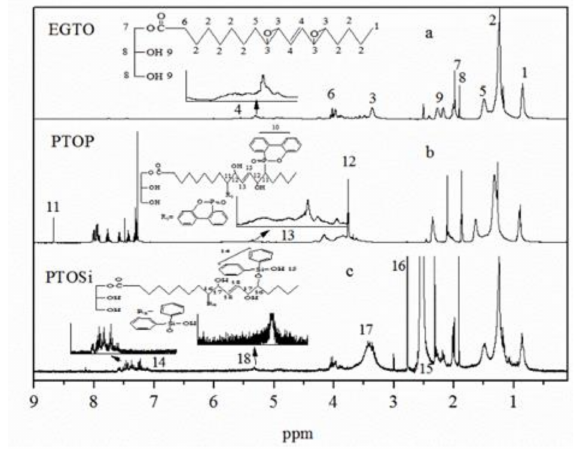
Figure 3. The 1 HNMR spectra of EGTO, PTOP, and